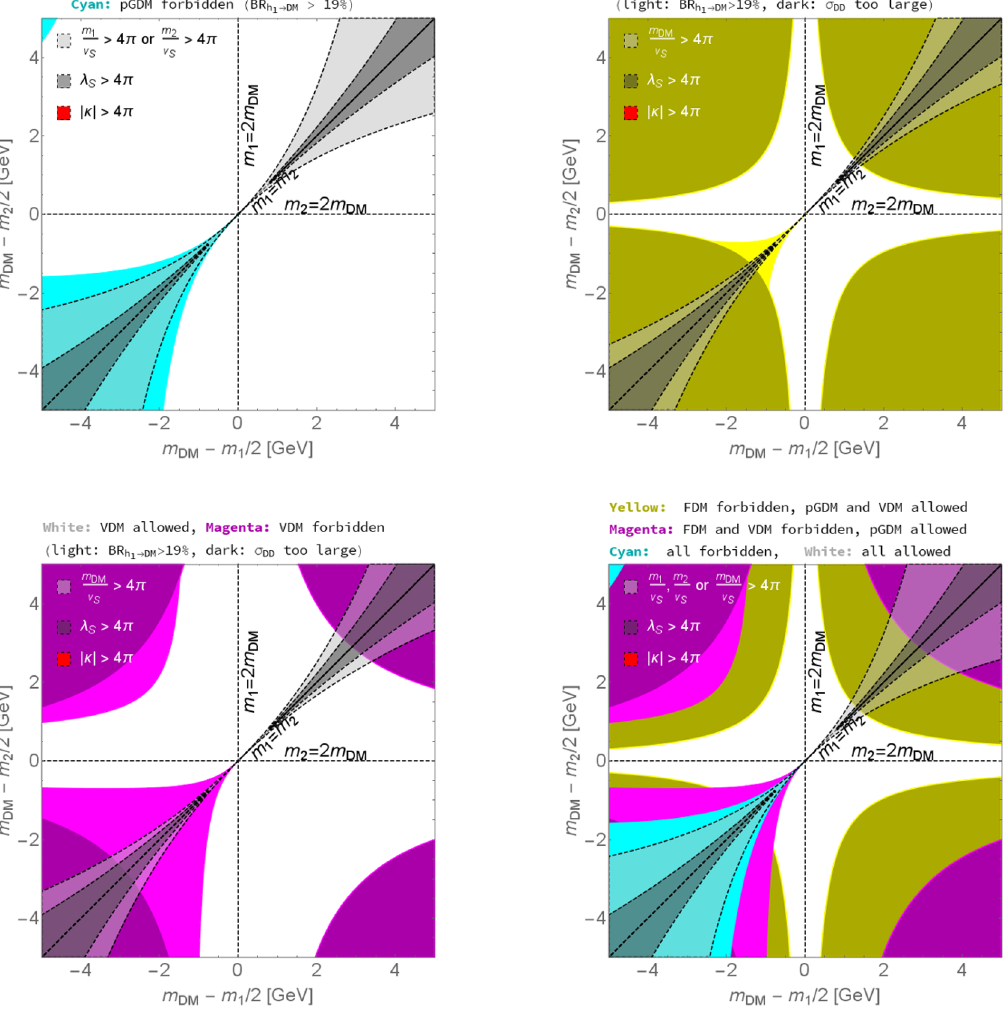
Figure 11 . The parameter space allowed or forbidden for the discussed models. Top-left: pGDM model, top-right: FDM model, bottom-left: VDM model, bottom-right: the three models combined. Light- and dark-gray regions denote violation of perturbativity conditions (5.14). Note that the j (cid:20) j < 4 (cid:25) condition is not violated in any place of the considered range of parameters.